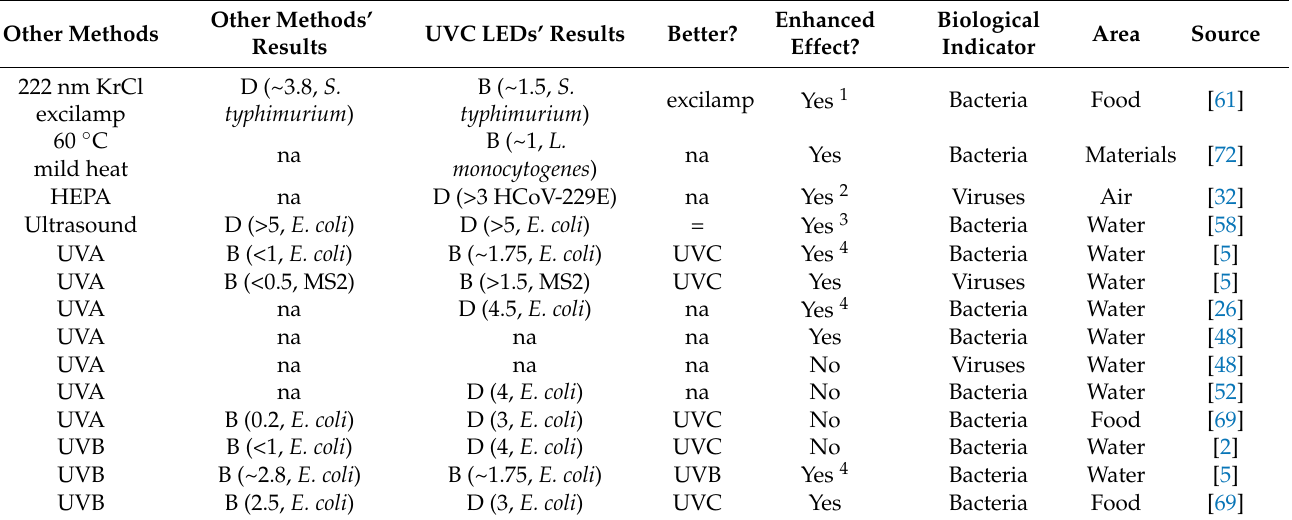
Table A3. Comparison between the decontamination effectiveness of UVC LEDs and physical